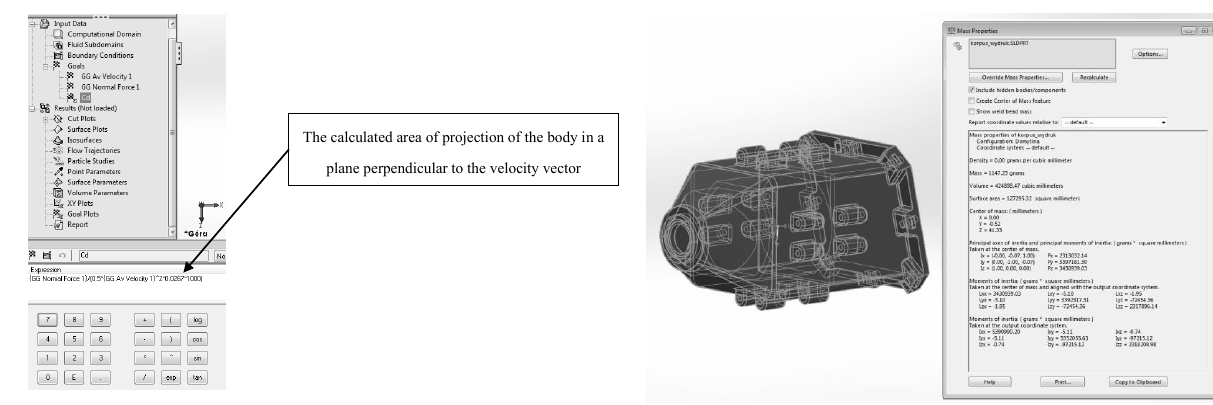
Fig. 5. Defining the CFG grid density